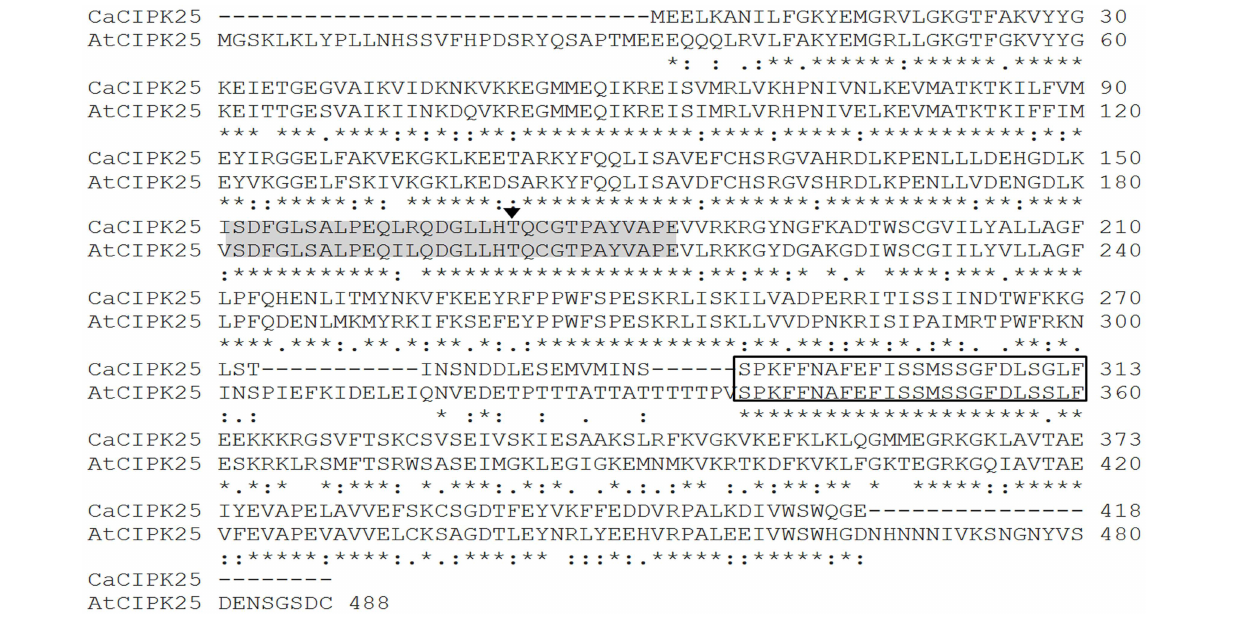
Frontiers in Plant Science |